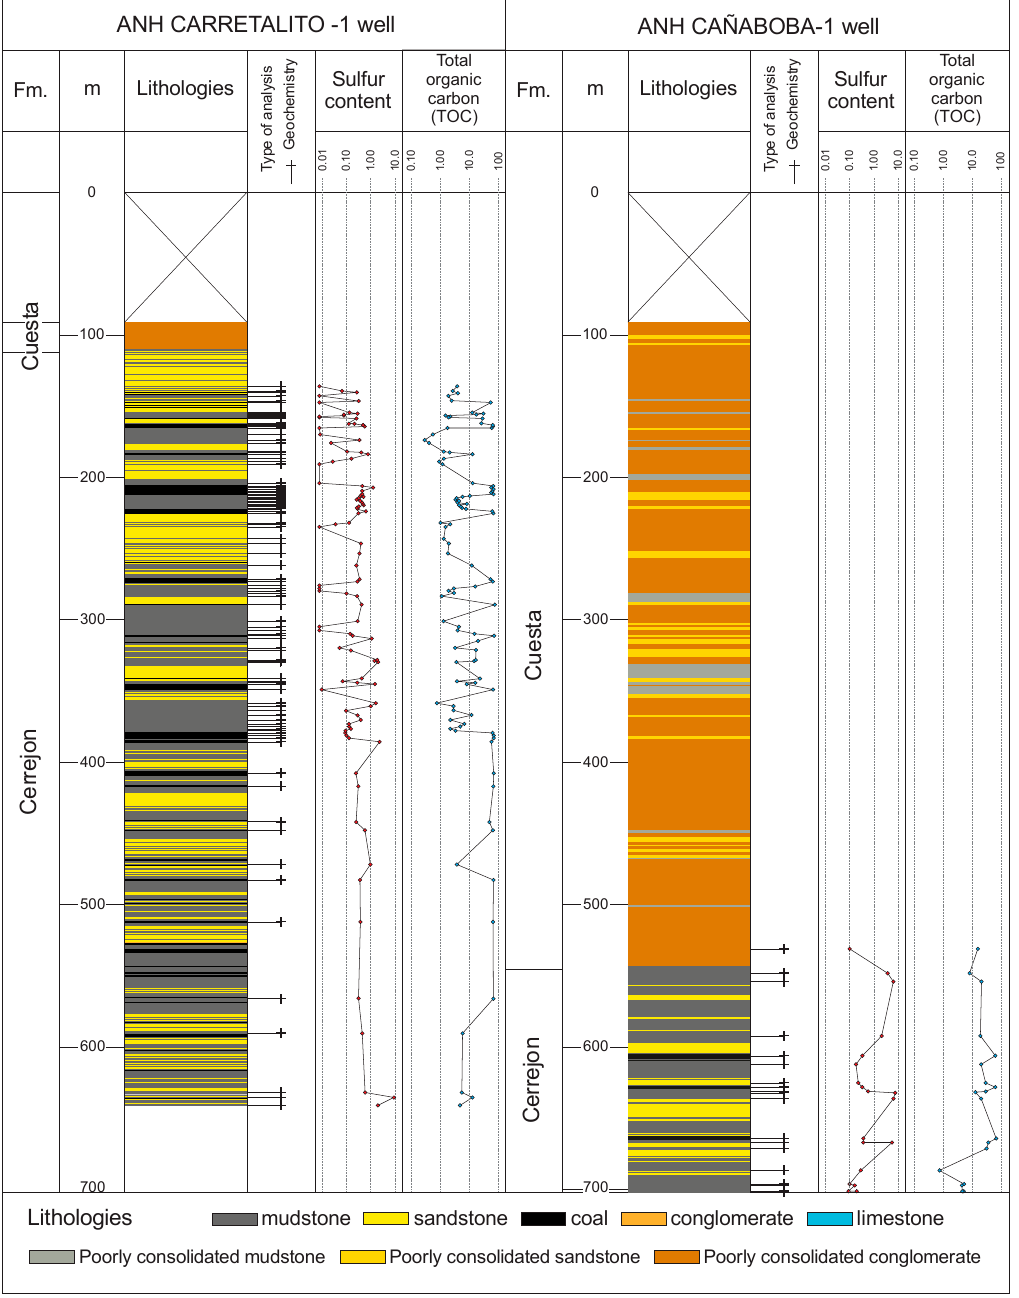
Figure 3. Lithologies, sample site (+), and variation of sulfur content and total organic carbon (TOC) of the rock samples of the Cerrejón Formation in the ANH-CARRETALITO-1 and ANH- CAÑABOBA-1 wells.